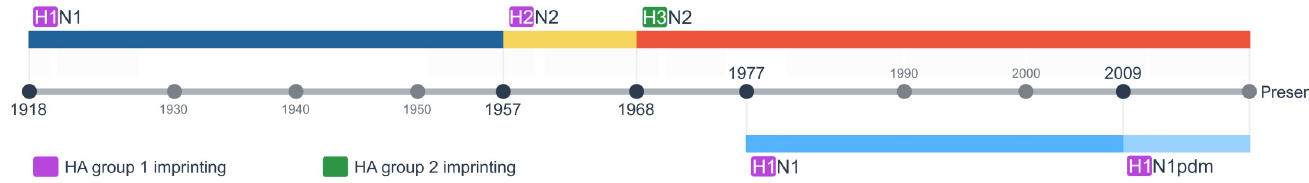
Fig 1. Timeline of influenza A virus circulation in humans from 1918 to present. Colored boxes represent different eras of influenza A subtype circulation and, hence, imprinting of population cohorts by different subtypes. Group-level imprinting is indicated as purple shading for group 1 (H1 and H2 viruses) and in green for group 2 (H3 virus). Cohorts born after 1977 can be imprinted by either group due to cocirculation of H1 and H3